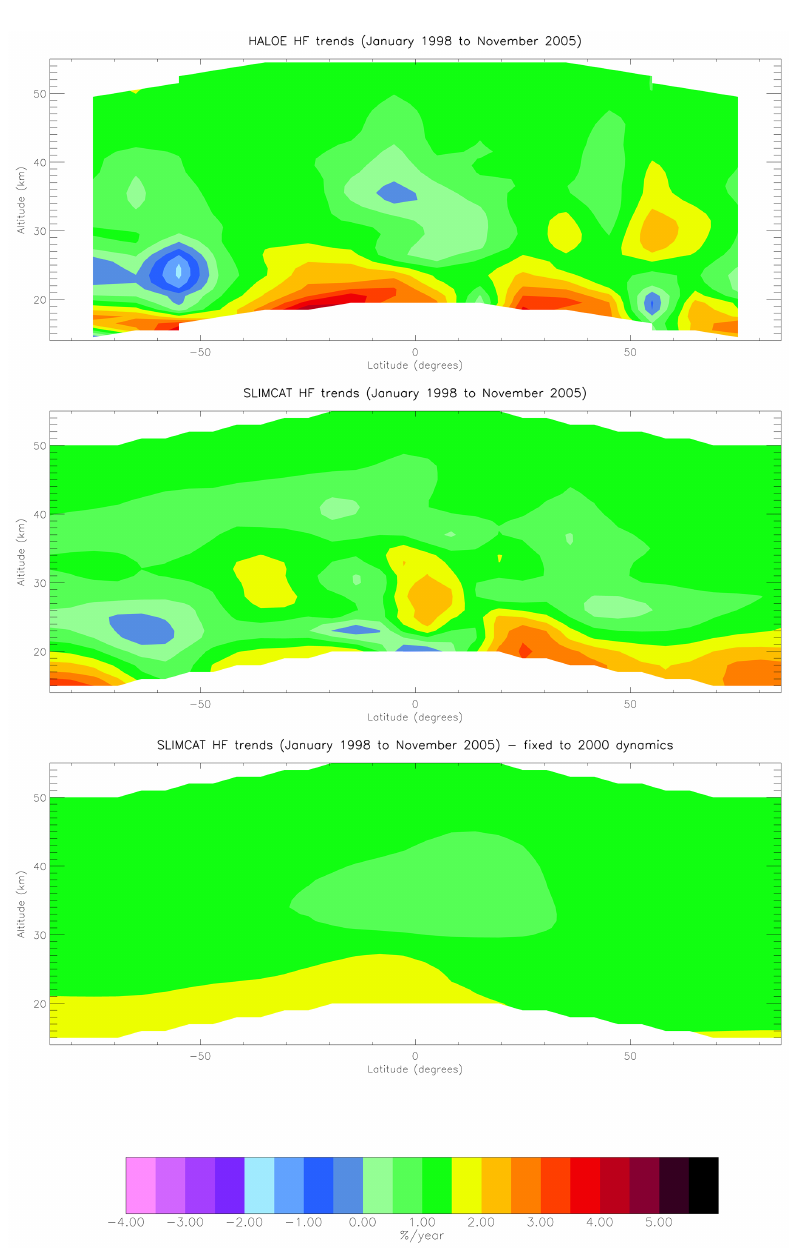
Figure 11. Trends in the growth of HF (%year − 1 ; January 1998 to November 2005) for HALOE and SLIMCAT as a function of latitude and altitude. A full discussion of these trends is provided in the